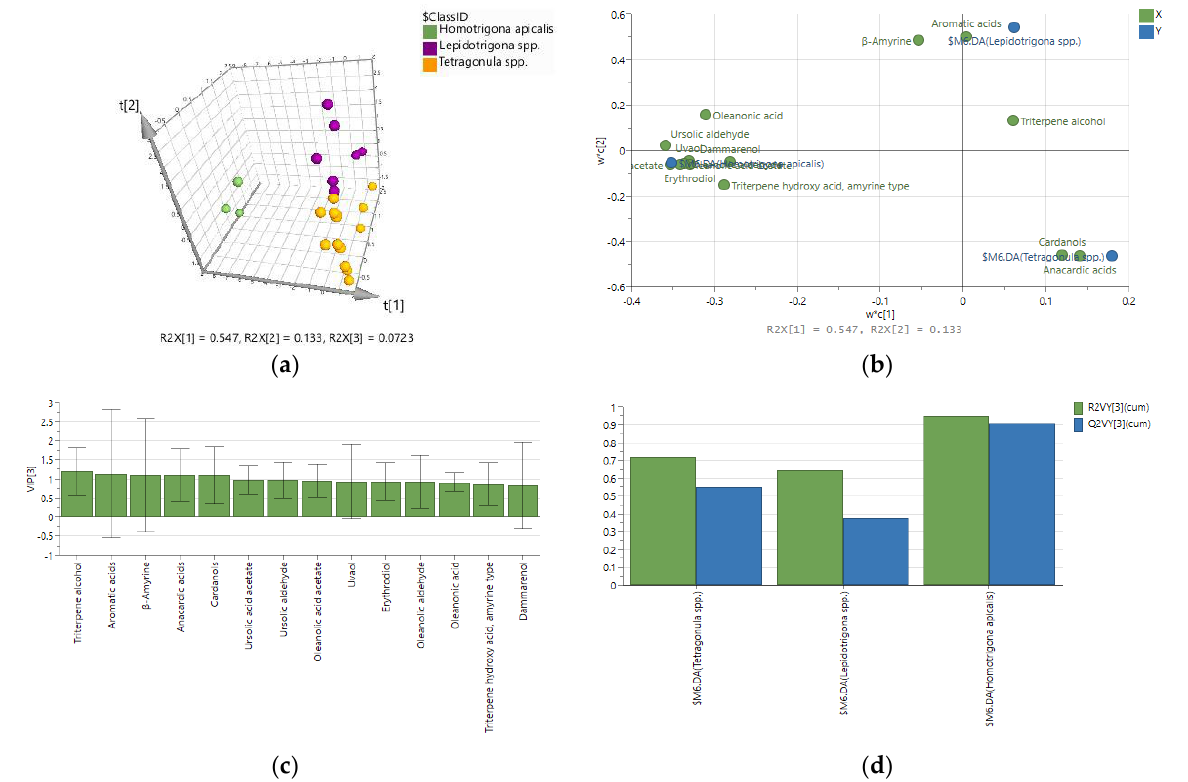
Figure 3. PLS-DA data for classification of 24 propolis samples based on 14 variables: ( a ) score plot; ( b ) loading plot; ( c ) variable importance in projection (VIP); ( d ) overall X/Y plot.